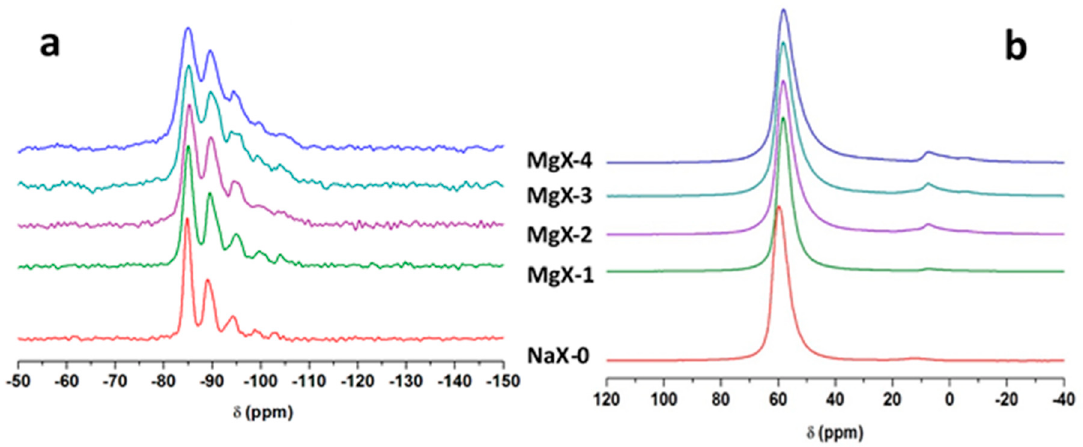
Figure 7. 29 Si-MAS NMR spectra ( a ) and 27 Al-MAS NMR spectra ( b ) of NaX-0 and its associated MgX-1 to MgX-4 samples. Only the isotropic region is shown.